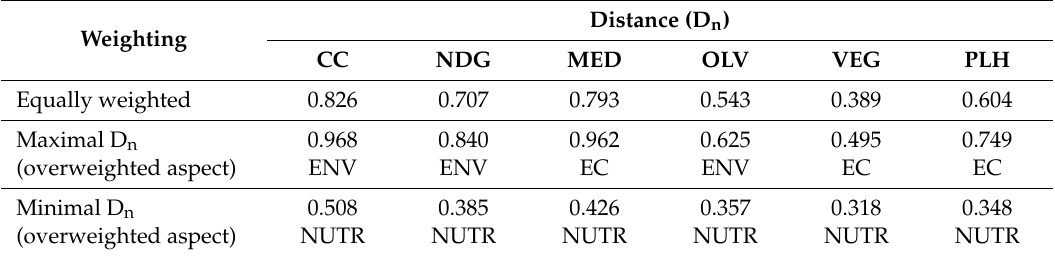
Table 3. Distances (Dn) of the pre-defined diets (including maximal and minimal